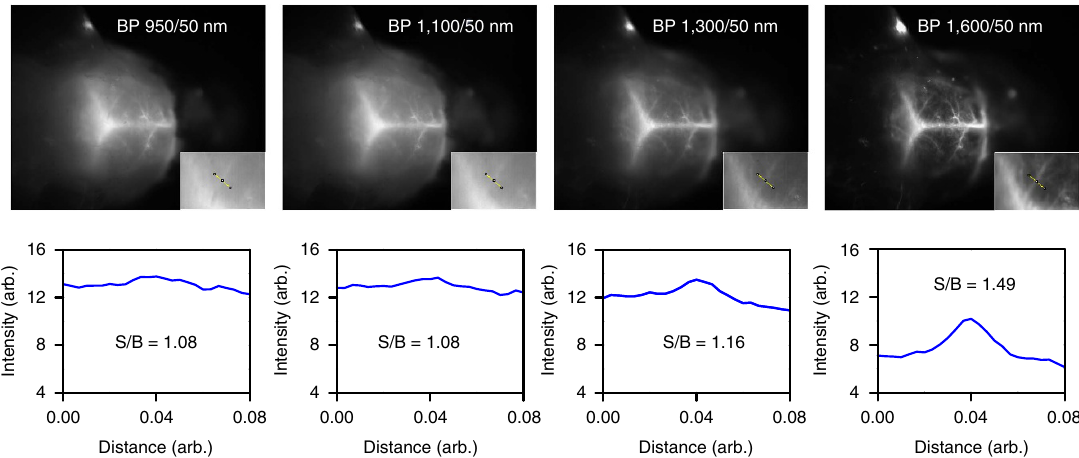
Figure 5 | Wavelength-selective SWIR imaging with CSS QDs. Fluorescence imaging of mouse brain vasculature through intact skin and skull using a mixture of SWIR CSS QDs. The four images were collected using four bandpass filters (50nm spectral width) centered at 950, 1,100, 1,300 and 1,600nm with integration times of 150, 50, 100 and 5,000ms, respectively. The images show that longer imaging wavelengths enhance the spatial resolution of fine vascular brain structures by significantly improving the signal to background (S/B) ratio in the region of interest, which stresses the need for SWIR emitters with high QYs and narrow emission at the red edge of SWIR